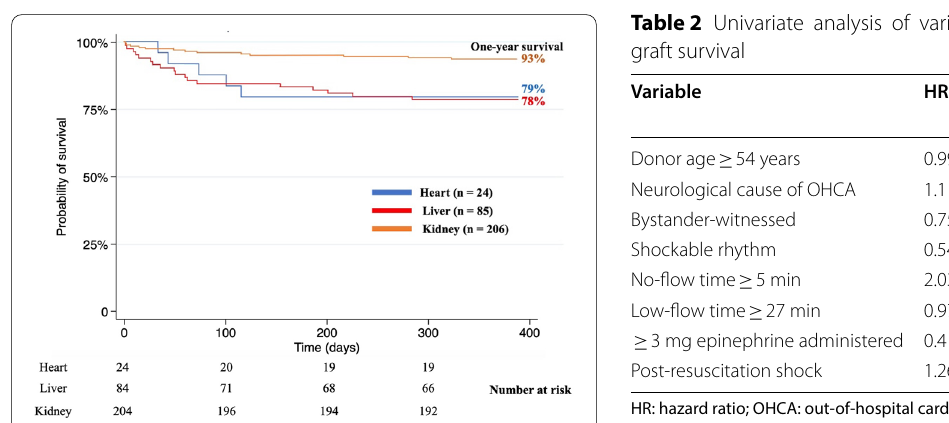
Fig. 3 Graft survival from donors with brain death after out-of-hospital cardiac arrest